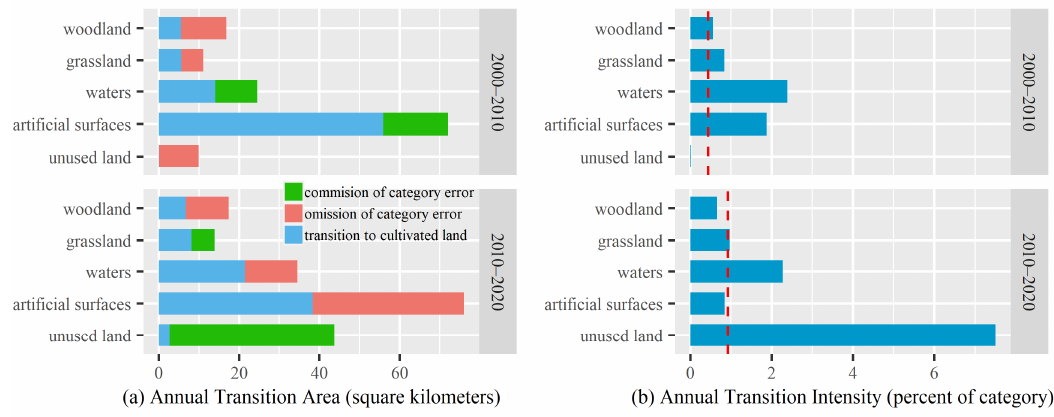
Figure 18. Intensity analysis for cultivated land gain in the lower reaches. The transition size along with hypothetical map errors ( a ); transition intensities ( b ). The red, vertical dashed lines indicate the uniform intensities.